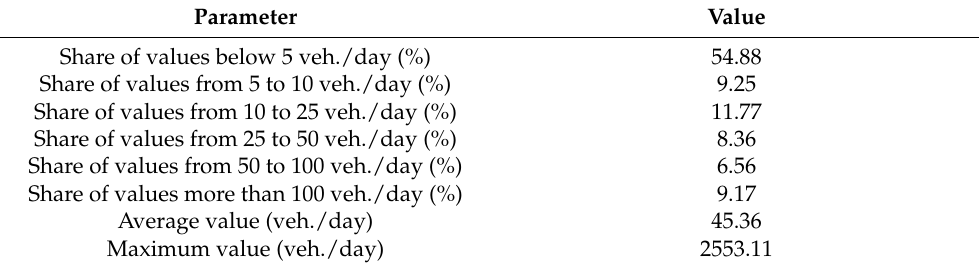
Table 2. Sample structure of traffic volumes generated by travels abroad.